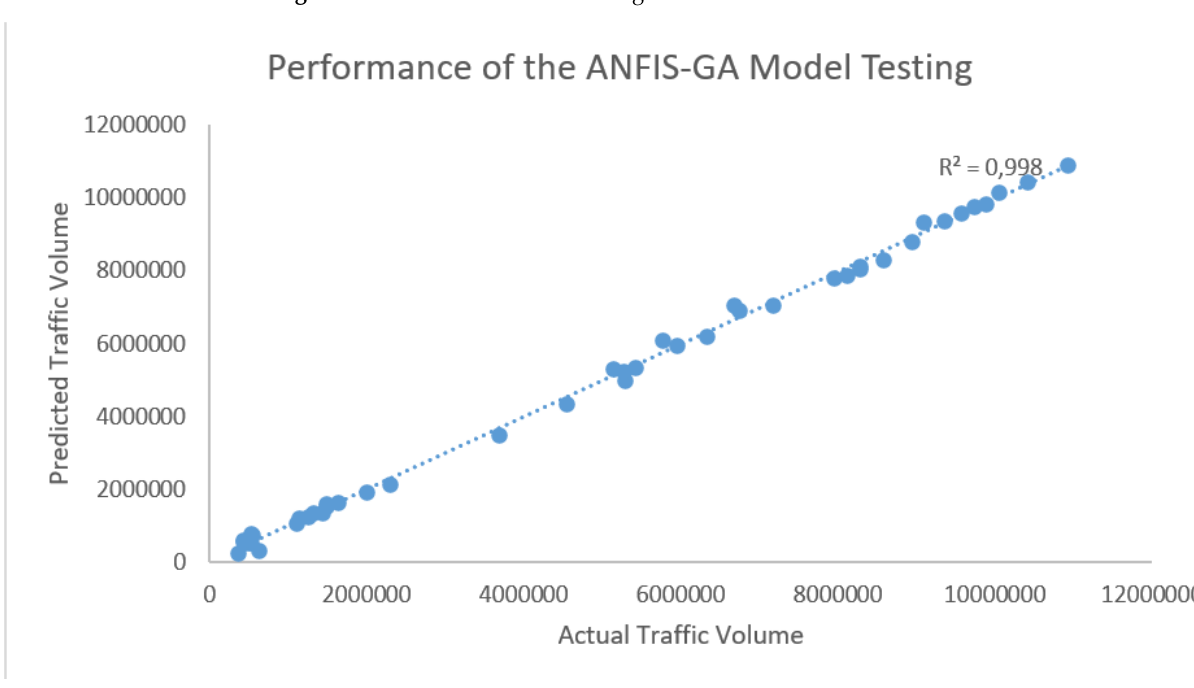
Figure 16. ANFIS-GA model testing.